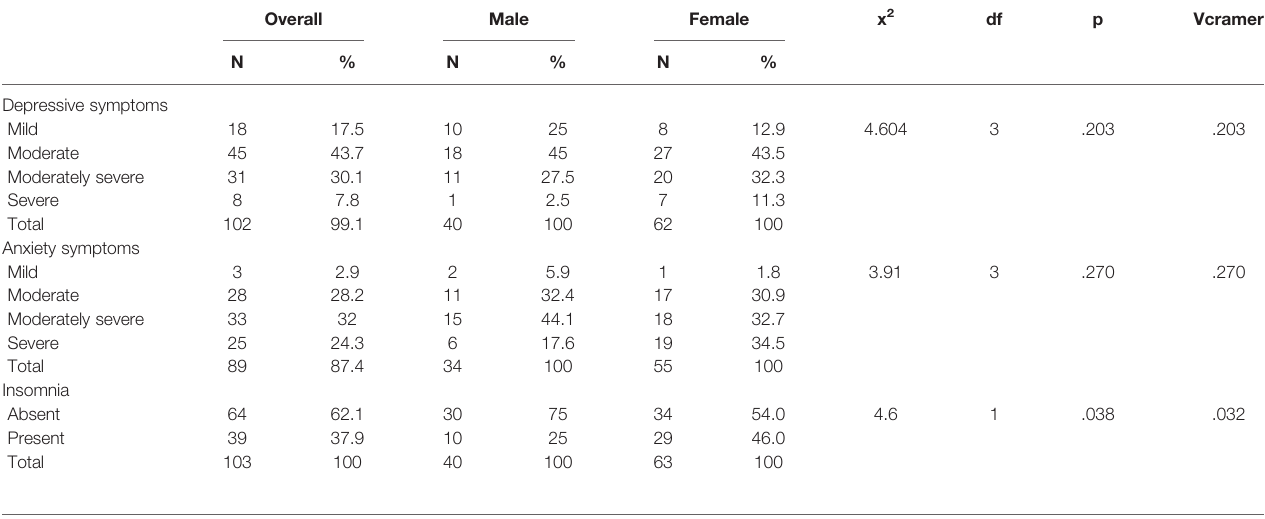
TABLE 3 | Participants ’ grouping according to psychometric scales ’ cutoff scores.